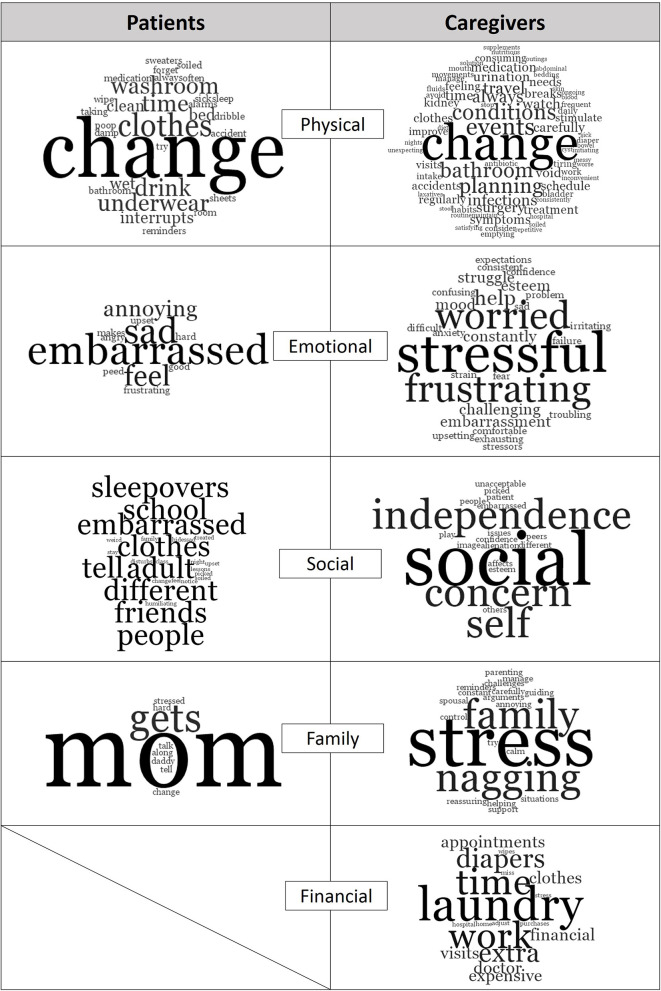
Study themes and most common words mentioned by patients and caregivers. Generated with NVIVO.